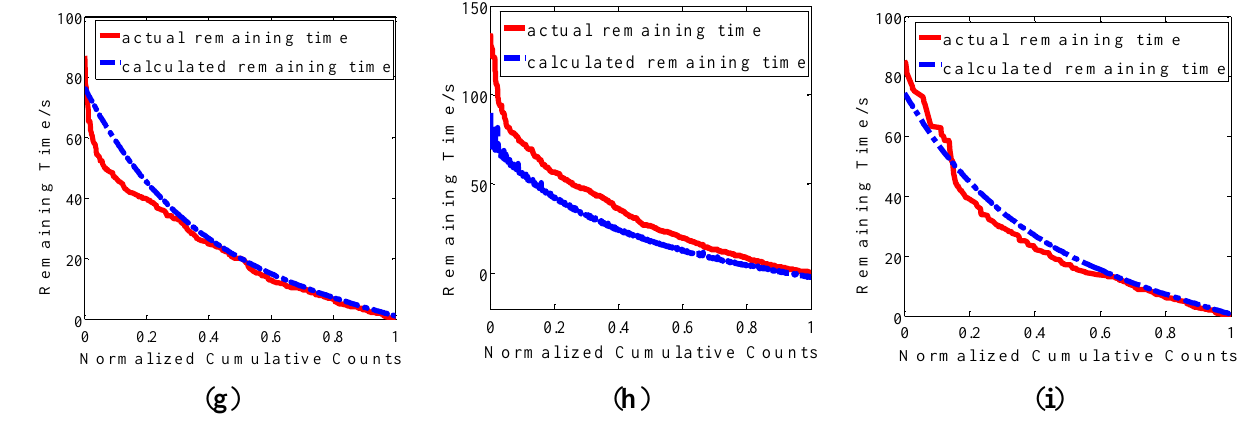
Figure 7. Comparison between the remaining time of elastic stage calculated from AE data and actual remaining time of the elastic stage in S1–S9. ( a ) S1; ( b ) S2; ( c ) S3; ( d ) S4; ( e ) S5; ( f ) S6; ( g ) S7; ( h ) S8; and ( i ) S9.